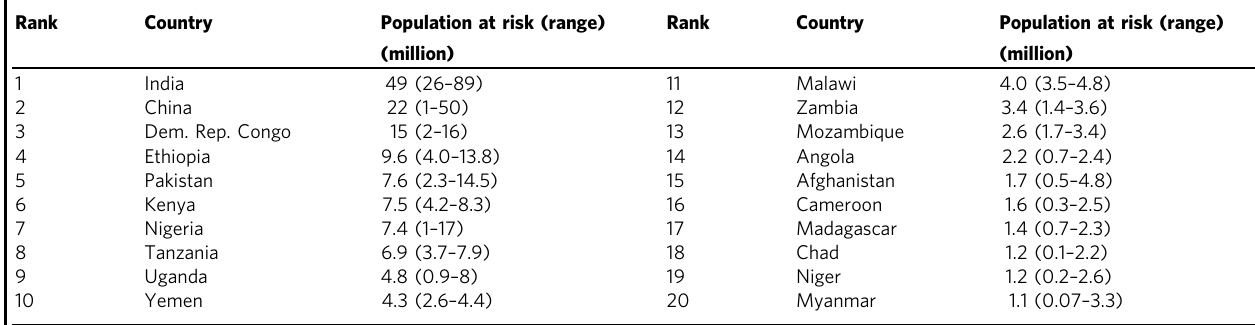
Table 1 Top 20 countries in population potentially affected by fl uoride concentrations in groundwater greater than 1.5 mg/L.